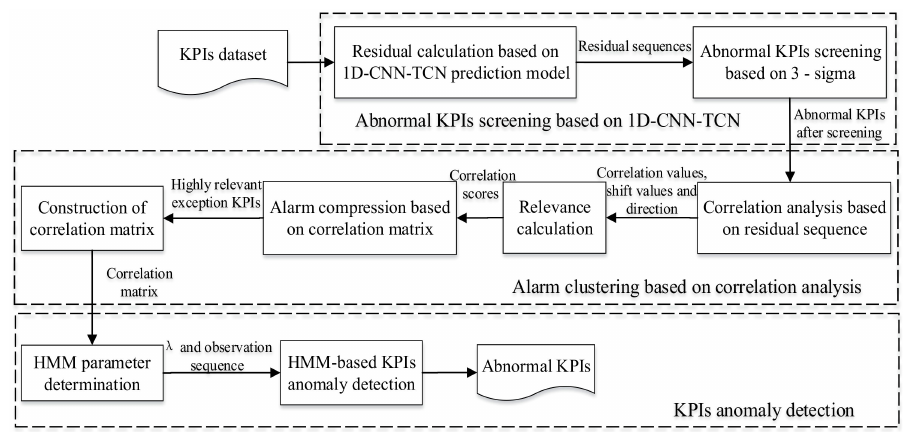
Figure 1. Method flow